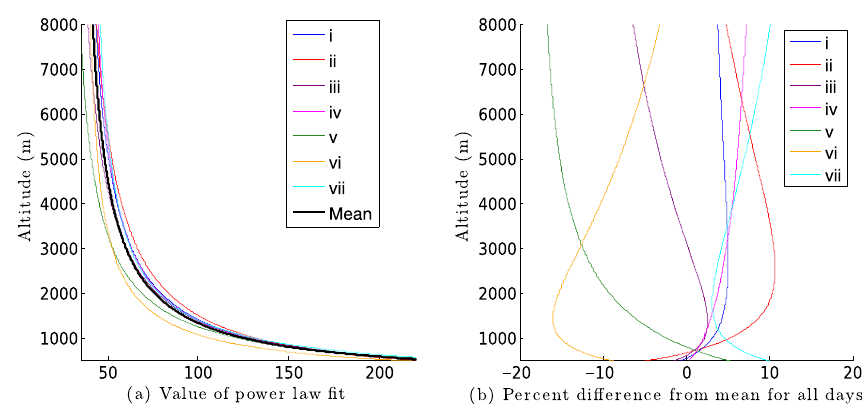
Figure 7. (a) Plots of second-order power law fits to the calculated profiles of Y(z) for the test dates and resolutions listed in Table 1. (b) Residuals of each profile from the mean power law fit profile. Compare this panel to Fig. 6a. The residuals are of similar magnitude to the uncertainties in the individually measured Y(z) profiles.